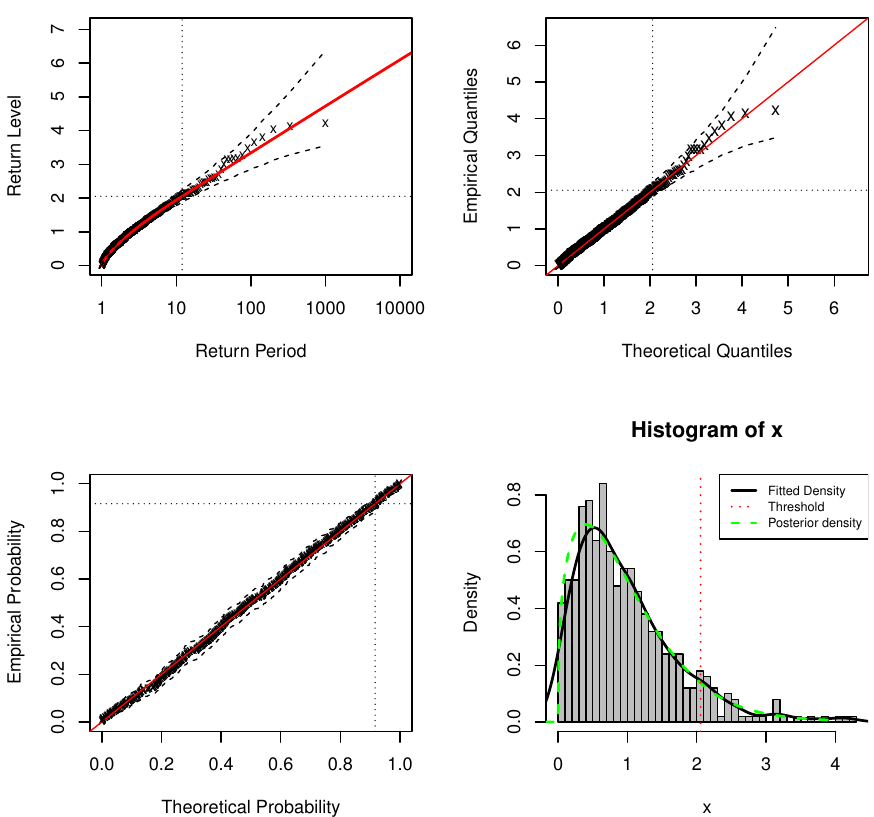
Figure 2. Standard model fit diagnostics for the DPMW-PPR model fitted to the simulated data with n = 500. (The top left corner is the return level plot, the top right corner is the quantile plot, the bottom left corner is the probability plot, and the bottom right corner is the density